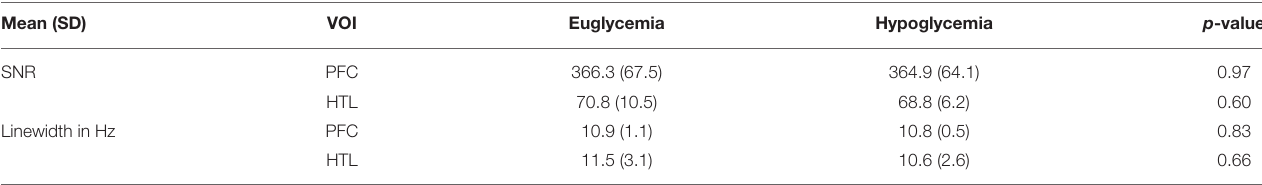
TABLE 2 | Signal-to-noise ratio (SNR) and linewidth (full-width at half-maximum) of water reference spectra for both volumes of interests (VOIs) during euglycemic and hypoglycemic glucose clamps in patients with type 1 diabetes ( N = 6).